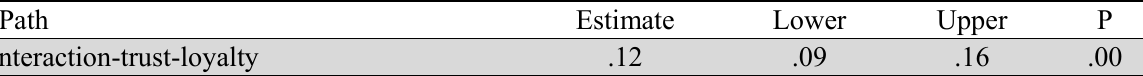
Mediation analysis bootstrapping results Path Estimate Interaction-trust-loyalty